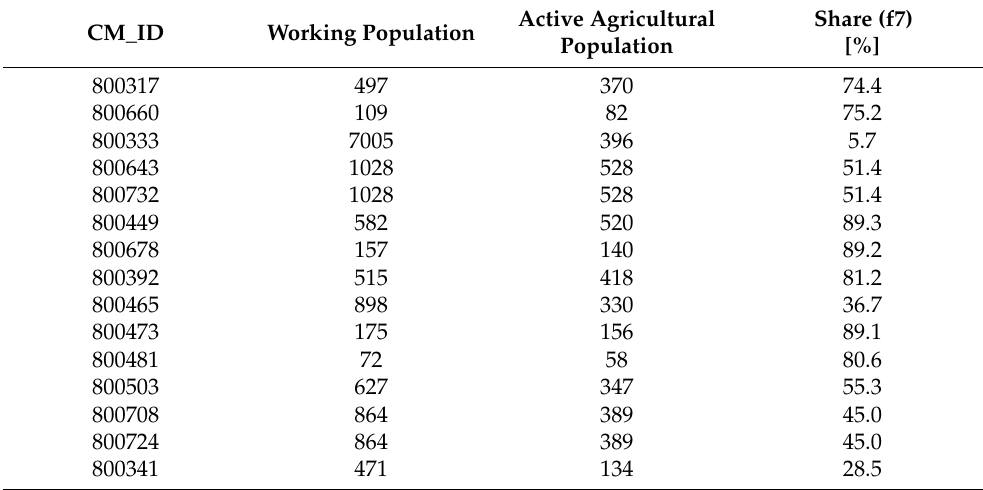
Table 3. Active agricultural population by land consolidation areas.